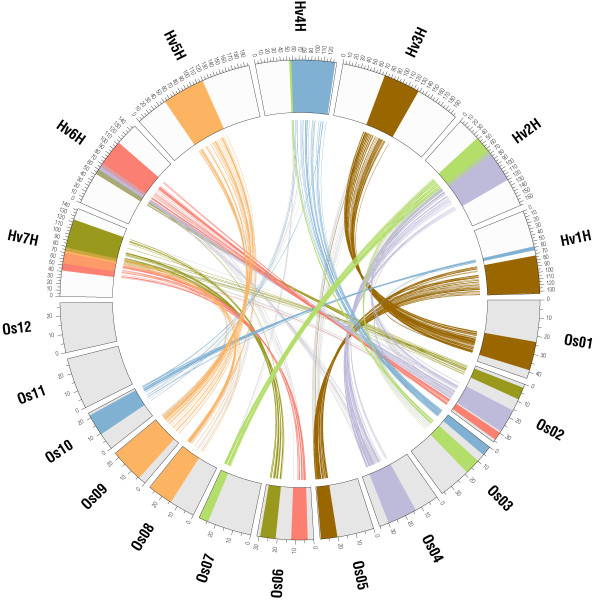
Inferring barley genome duplications using the synteny to rice. At least seven barley genome duplications could be inferred by analyzing the location of mapped ESTs among the seven barley chromosomes (Hv1H – Hv7H) and their best rice homologs (putative orthologs) among the 12 rice chromosomes (Os01 – Os12) with respect to rice segmental genome duplications (indicated by connecting lines of the same color). Relationships between second-best rice homologs (putative paralogs) of the same markers to the corresponding paralogous region in rice are shown in grey. Two hypothetical additional AD's involving Hv5H – Os03/Hv2H – Os07 and Hv4H – Os11/Hv5H – Os12 confirmed by less than 8 orthologous gene pairs to one of the duplicated rice regions are not shown.